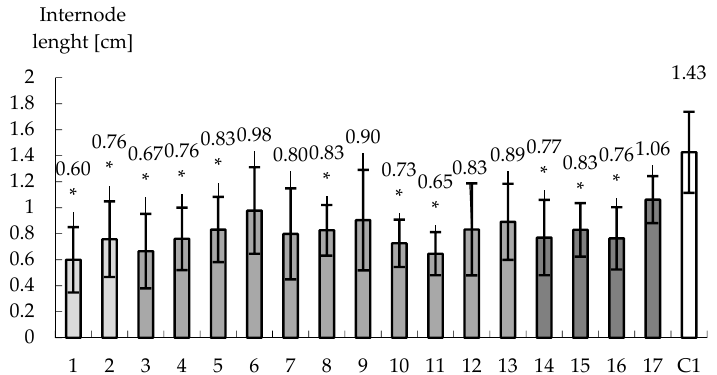
Figure 5. The evolution of internodes length for 18 tobacco clones studied and originating from hypocotyls that have been submitted to drought stress such as ABA (1 and 2), PEG (3–13), ABA & PEG (14–17). It is obvious the significant decrease in internodes length and in certain clones at half compared to control. * Significant differences: p < 0.05.